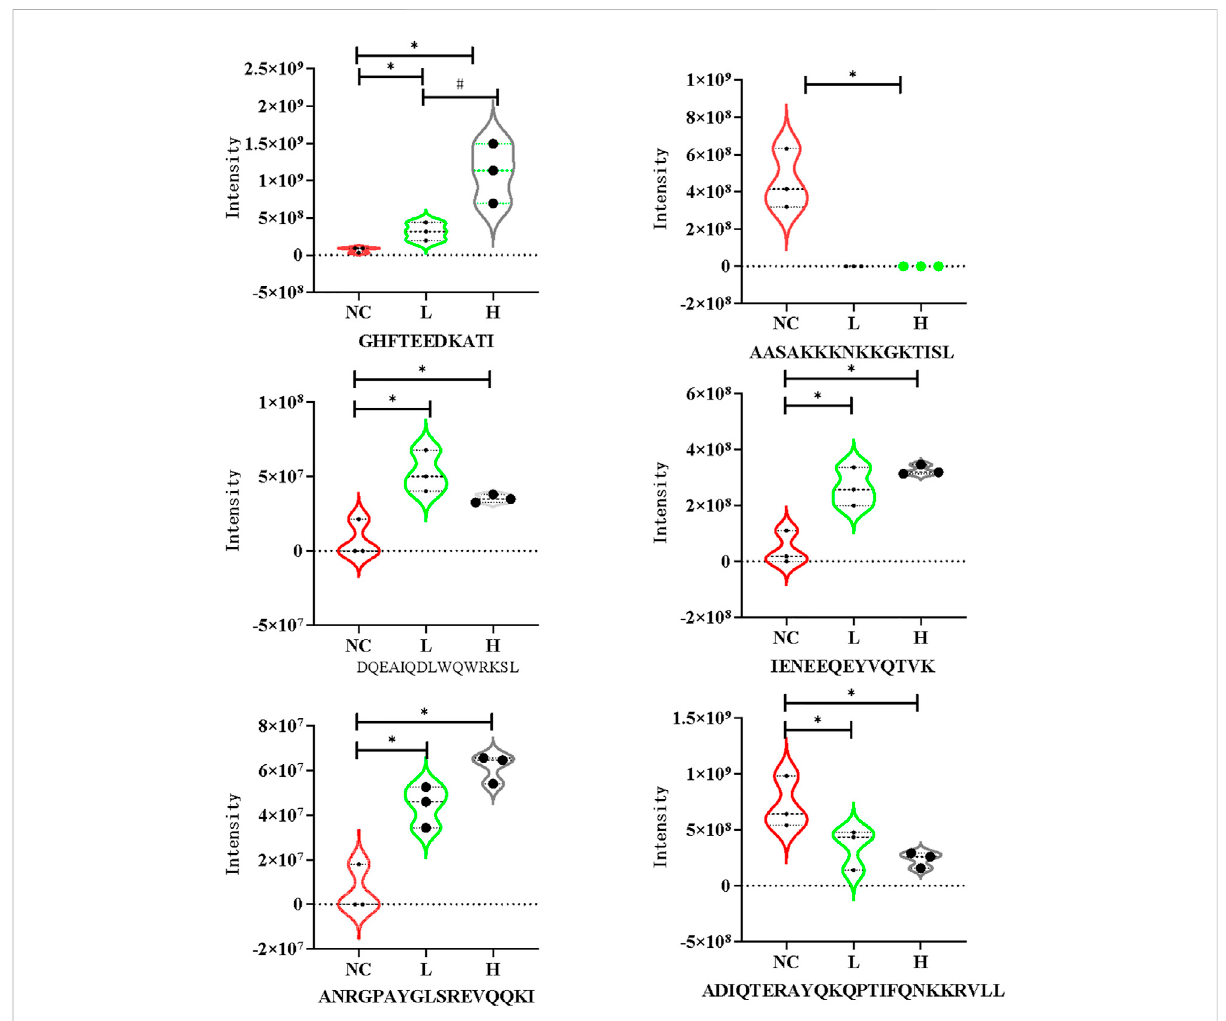
FIGURE 4 Violin plots of DEPs in the mild PE, severe PE and control group. L, mild PE; H, severe PE; NC, control group. *, represent p < 0.05 compared to the control group #, represent p < 0.05 compared to the mild PE